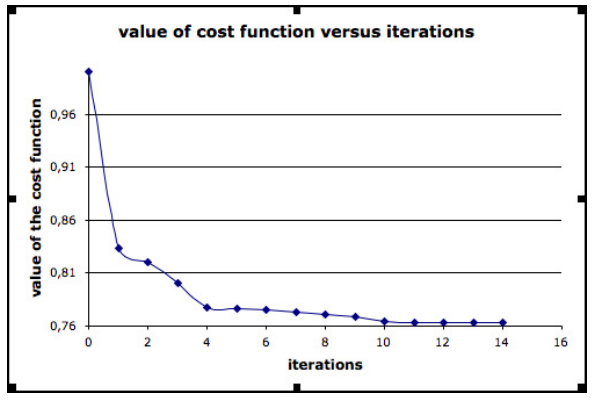
Fig. 14. Helix curve before (black) and after (grey) optimiza- tion.